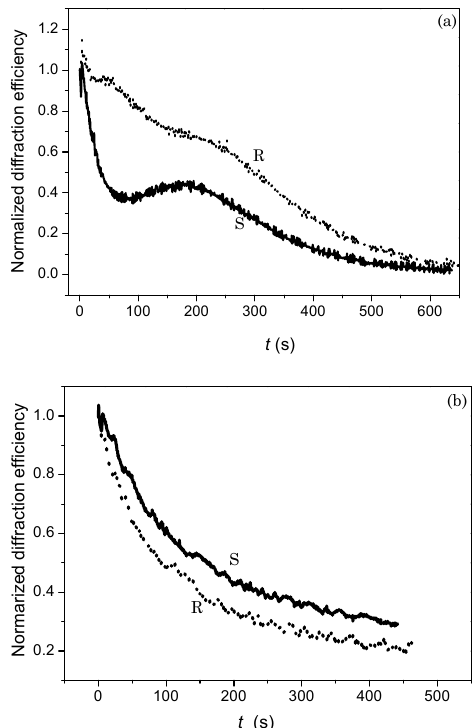
Figure 1. Erase curves of as-grown state Sc:Ru:Fe:LiNbO 3 crystal at ( a ) 476 nm wavelength and ( b ) 633 nm wavelength.